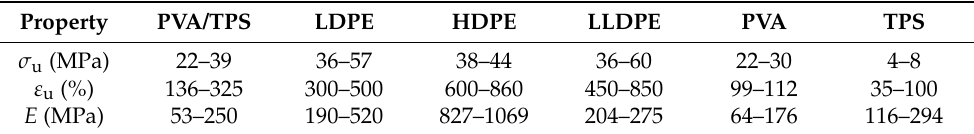
Table 2. Range of PVA/TPS mechanical properties compared to those for typical polyethylene film materials (low-density polyethylene (LDPE), high-density polyethylene HDPE, linear low-density polyethylene (LLDPE)) [51], PVA [52], and TPS [53].